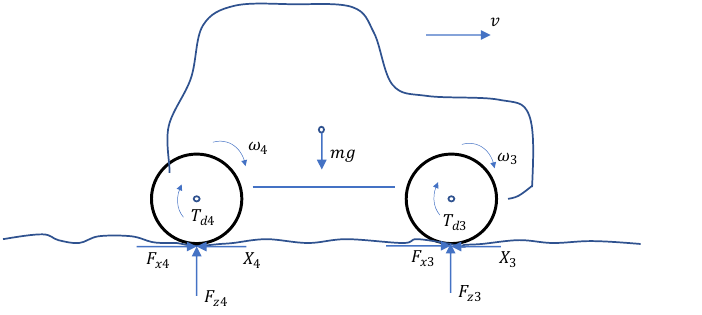
Figure 2. Hardware structure of the DDAV.